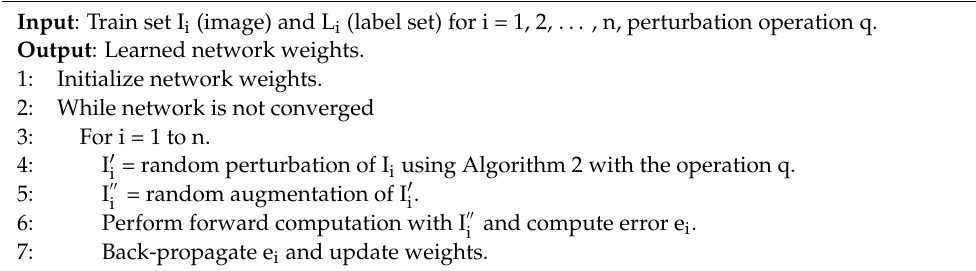
Algorithm 1. Network training with local feature